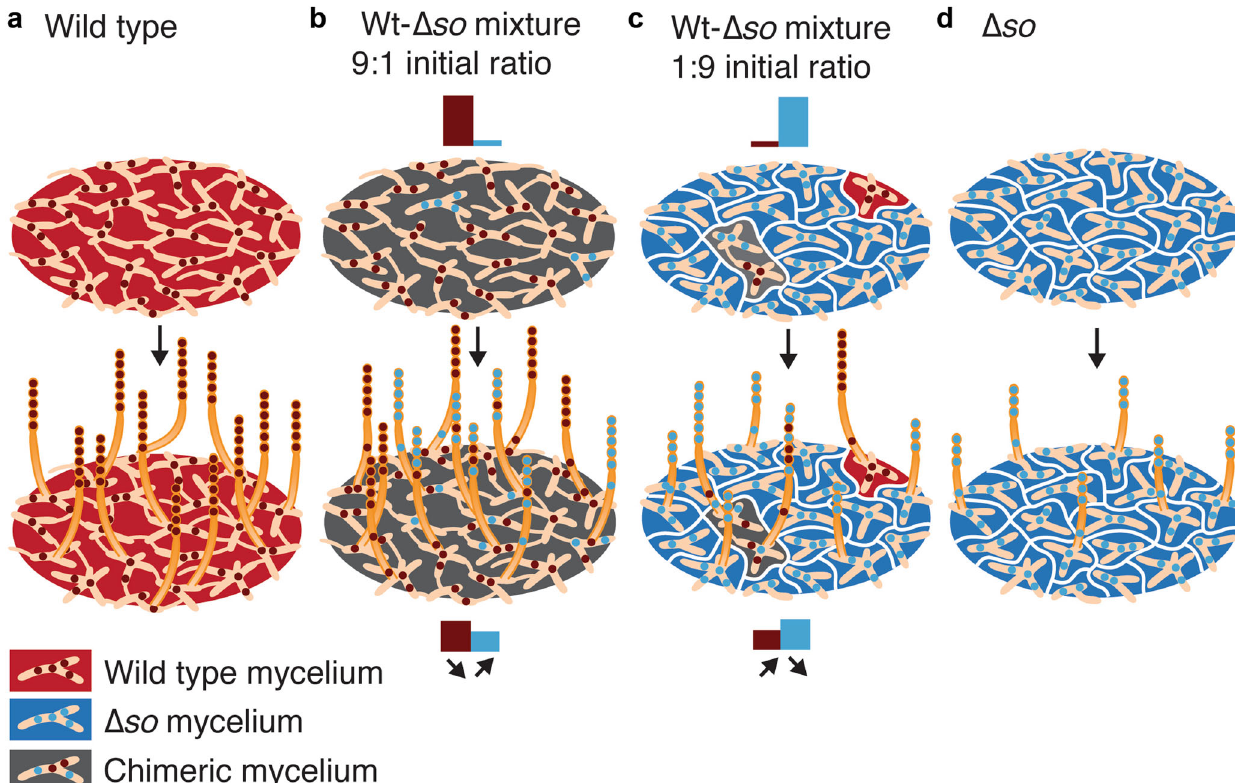
Fig. 4 Frequency-dependent selection of the Δ so cheater and consequences for spore production. a In a wild-type colony, frequent hyphal fusion allows ef fi cient resource distribution within a mycelial network for optimal development of reproductive aerial hyphae. b At low frequency, Δ so cheaters are surrounded by connected wild-type hyphae, and have a high chance that at least one wild-type hypha will fuse with them. This gives cheaters access to well-connected wild-type mycelia, and since the cheater nuclei make hyphae less likely to participate in fusion, they have a higher likelihood to become overrepresented in the reproductive aerial hyphae. c However, when Δ so cheaters reach high frequencies the culture becomes fragmented (white borderlines) and Δ so mycelia will often remain unconnected to wild-type hyphae. This reduces total spore yield, and provides a relative bene fi t to wild-type patches that remain isolated from Δ so . d A Δ so monoculture sporulates very poorly because the somatic structures are maximally fragmented and unable to ef fi ciently mobilize resources to support the reproductive aerial hyphae. The bars indicate how the representation of Δ so cheater and wild type change from mycelium to restricted to a small size (~1 cm after a week growth), making feasible counting colonies (up to ~100) on a 9-cm Petri plate. On this medium after 7 days, wild-type colonies produced bright orange heavily-sporulating colonies, while most fusion mutants studied here ( Δ so , Δ ham-5 , Δ ham-6 , Δ ham-7 , and Δ ham-8 ) produced pale-orange, poorly-sporulating fl at colonies. Δ ham-3 , Δ ham-4 , produced larger but transparent colonies often with a mycelial rim. Δ mak-1 fusion mutant formed very small (a few mm) transparent colonies. These phenotypes allowed us to dis- tinguish the mutants from the wild type on counting plates (Supplementary Fig. 4). Sexual crosses . Sexual crosses were performed on slants with synthetic crossing medium (SCM) containing 2% sucrose as a carbon source 44 . As most mutants used in this study were female sterile 45 , we used them as males in sexual crosses as follows. Some asexual spores of the knockout mutants were spread onto the 1 d-old recipient female colony. The fertilized culture was incubated until the development of fruit bodies (for 2 – 3 weeks). The sexual spores were then shot out of the fruit bodies and became visible on the inside of a glass tube as a black fi lm. The sexual spores were collected with a wet cotton swab and were given the required heat shock for 30min at 61°C to activate germination, but also to kill the residual asexual spores and mycelial fragments. After the heat shock, the sexual spores were spread onto the counting plates supplemented with hygromycin B ( fi nal con- centration 200 μ g/ml). Since single-gene knockouts were constructed by sub- stituting the gene of interest with a hygromycin cassette, the mutants are resistant to hygromycin, making it a selectable marker 42 . A control plate without hygro- mycin was used to check whether the re-constituted wild-type strain, which lacks hygromycin resistance, would grow along with the rest of the progeny. The can- didate progeny colonies were transferred into slants with VMM, checked for the phenotype, tested for the inl or pan de fi ciency, and for the mating type. The mating type was determined by inoculating asexual spores onto 3 – 5 d-old colony (acted as female) of tester strains ( Δ fl :: Hyg r ; mat A and Δ fl :: Hyg r ; mat a) and checked for the